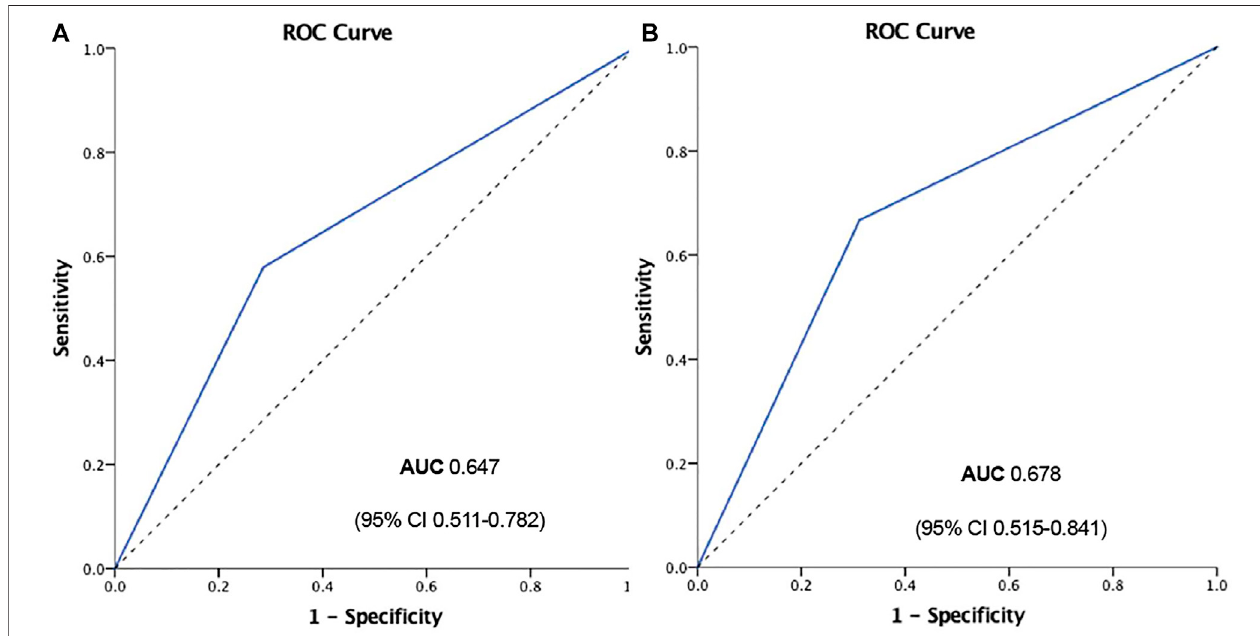
FIGURE7| ROCcurveofCPFD-caIMRpredictingtheeventgroupincludingCVdeathsorheartfailurereadmission(CorH)before (A) andafter (B) propensityscore matching. Abbreviations: CPFD, computational pressure- fl uid dynamics; caIMR, coronary-angiography-derived index of microcirculatory resistance; CV, cardiovascular; ROC, Receiver Operating characteristic; AUC, Area under